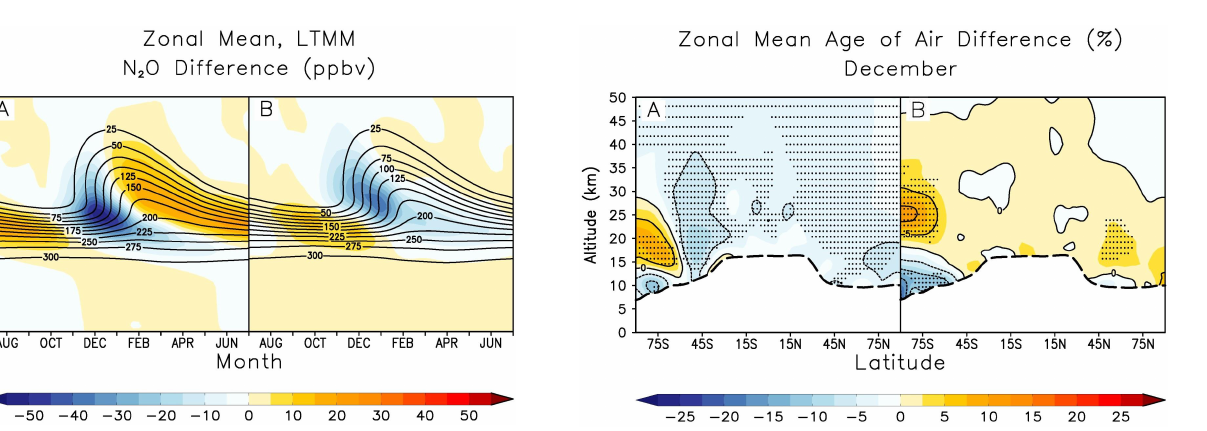
Figure 9: December zonal and monthly mean age-of-air differences in percent for experiment Figure 8: Time-height cross sections of N 2 O and N 2 O differences. Isolines: Absolute values of Fig. 8. Time-height cross sections of N 2 O and N 2 O differences. Fig. 9. December zonal and monthly mean age-of-air differences in pair A (left) and experiment pair B (right). Positive differences are shown in warm colours and long-term monthly mean (LTMM) N 2 O (parts per billion by volume, ppbv) averaged over all Isolines: absolute values of long-term monthly mean (LTMM) N 2 O percent for experiment pair A (left) and experiment pair B (right). negative in cold colours. The black dashed line indicates the position of the tropopause in the latitudes south of 70°S for runs subtracted in pair A (left) and pair B (right). Shadings: Absolute “Control” cases. Differences that exceed one standard deviation of the ‘Control’ are stippled. (parts per billion by volume, ppbv) averaged over all latitudes south Positive differences are shown in warm colours and negative in differences in N 2 O (ppbv) for experiment pair A (left) and experiment pair B (right). Positive differences are shown in warm colours and negative in cold colours. of 70 ◦ S for runs subtracted in pair A (left) and pair B (right). Shad- cold colours. The black dashed line indicates the position of the ings: absolute differences in N 2 O (ppbv) for experiment pair A (left) tropopause in the “Control” cases. Differences that exceed one stan- and experiment pair B (right). Positive differences are shown in dard deviation of the “Control” are warm colours and negative in cold colours.